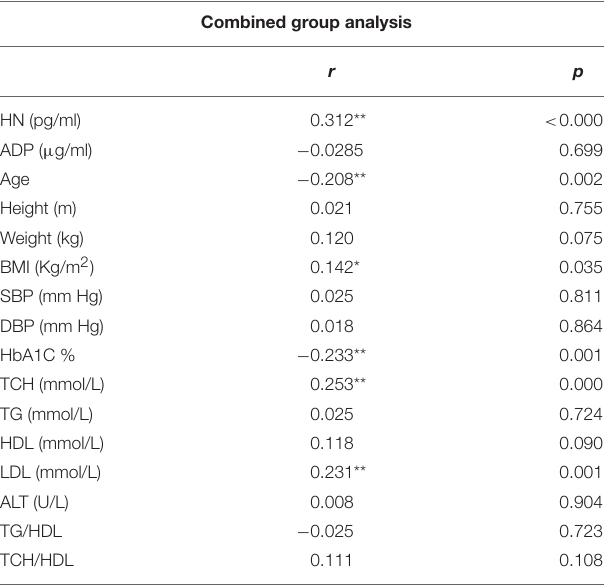
TABLE 2C | Spearman Rank correlation bivariate analysis of variables associated with MOTS-c.